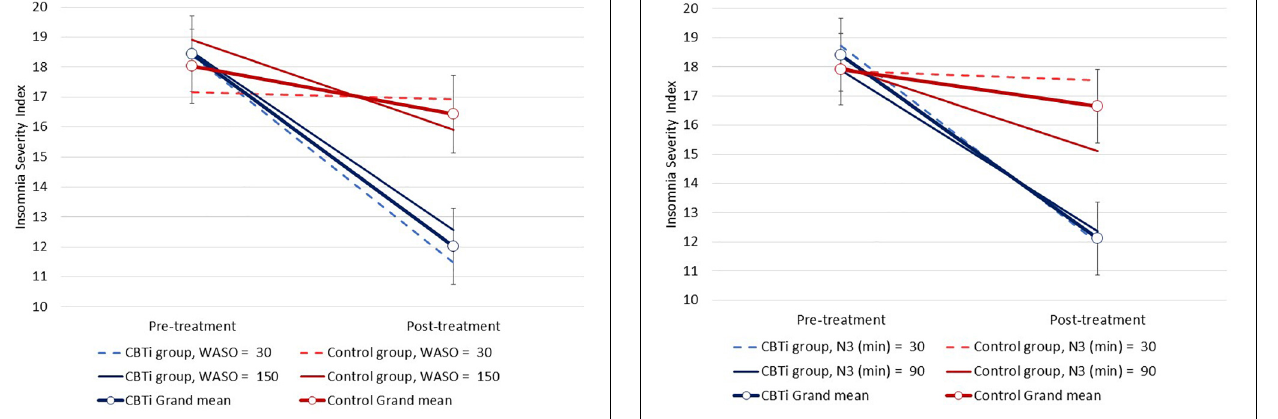
FIGURE 3 | Modeled data illustrating the effect of pre-treatment wake after sleep onset (WASO; min), group (CBTi, control), and time (pre-treatment, post-treatment) on the Insomnia Severity Index (CI). Pre-treatment WASO was retained as a continuous predictor and data are plotted according to intercept, slopes and interaction effects. Compared to control, lower pre-treatment WASO predicted greater insomnia severity reduction in the CBTi group.